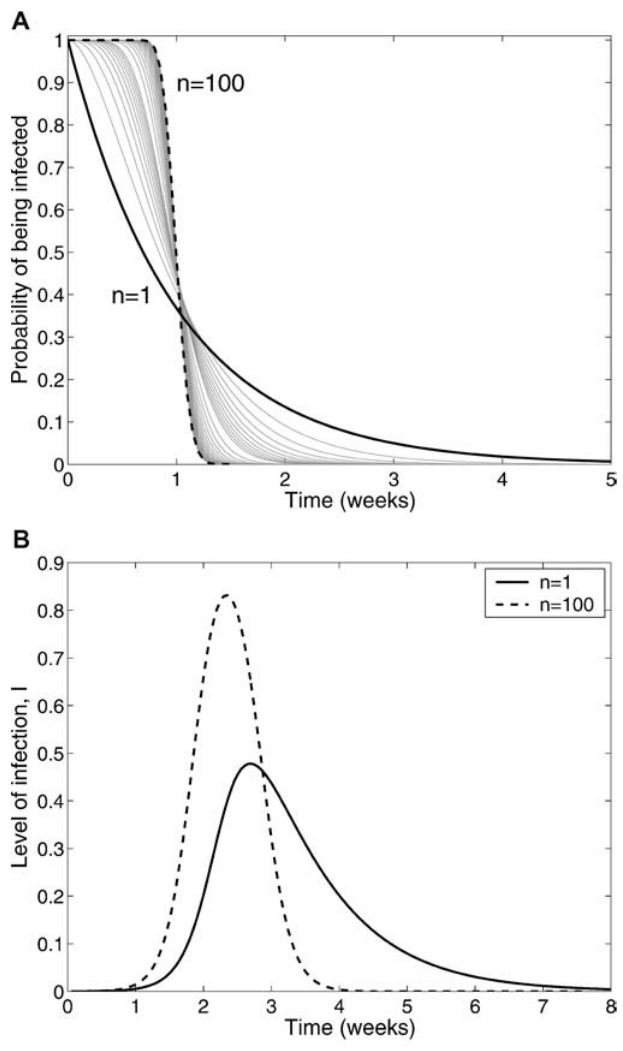
Figure 1. Gamma-Distributed Infectious Periods and Their Effects on the Epidemic Curve (A) The change in the probability of remaining infectious as a function of time when the number of subdivisions within the infected class increases from n ¼ 1 to n ¼ 100. Irrespective of the value of n, the mean duration of the infectious period is 1 wk. When n ¼ 1, the distribution of the infectious period is exponential, but as n increases the infectious period becomes closer to a constant length. (B) The consequences of changes in n for the SIR-type epidemic without births or deaths. For the same basic reproductive ratio, R 0 ¼ 5, and the same average infectious period, c ¼ 1, larger values of n lead to a steeper increase in prevalence and an epidemic of shorter duration. DOI: 10.1371/journal.pmed.0020174.g001